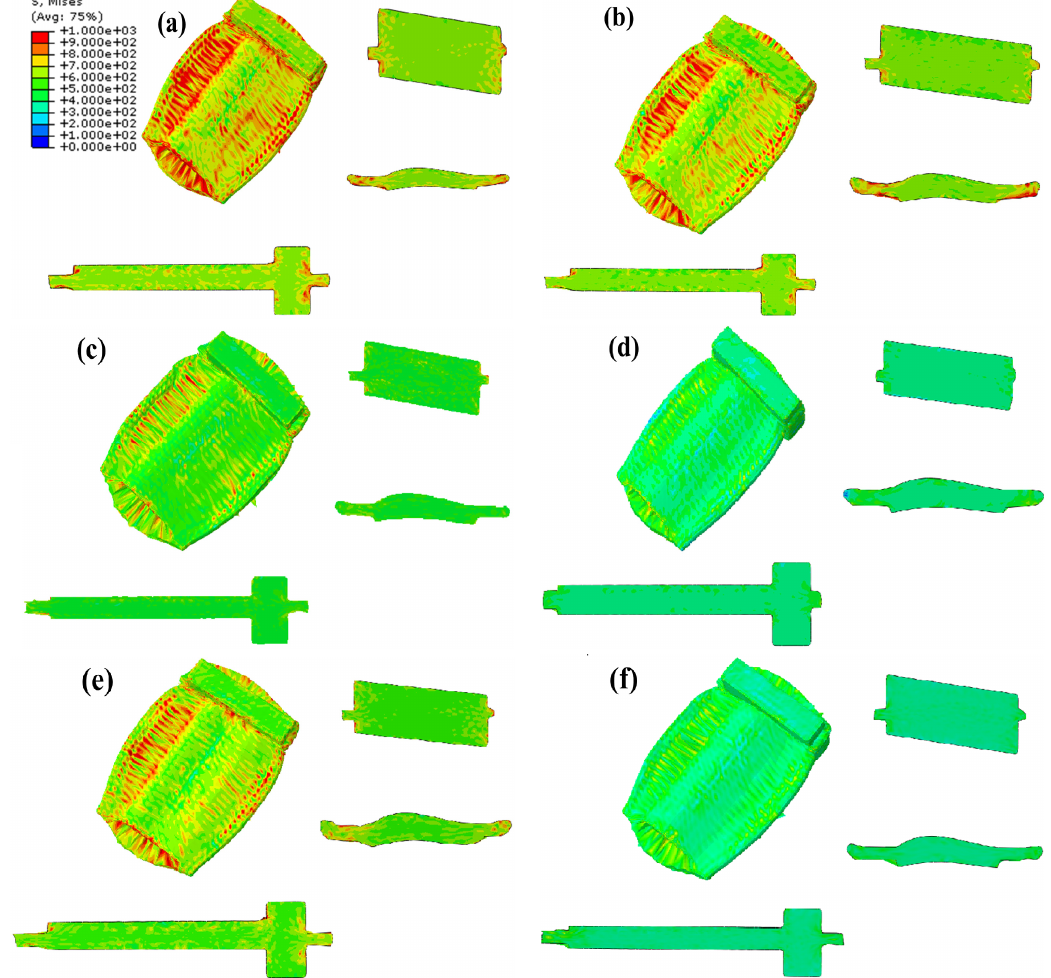
Figure 6. Effective stress distributions at different forging temperatures and strain rates: ( a ) 900 ◦ C, 0.01 s − 1 ; ( b ) 930 ◦ C, 0.01 s − 1 ; ( c ) 950 ◦ C, 0.01 s − 1 ; ( d ) 1000 ◦ C, 0.01 s − 1 ; ( e ) 950 ◦ C, 0.05 s − 1 ; ( f ) 950 ◦ C, 0.005 s − 1.